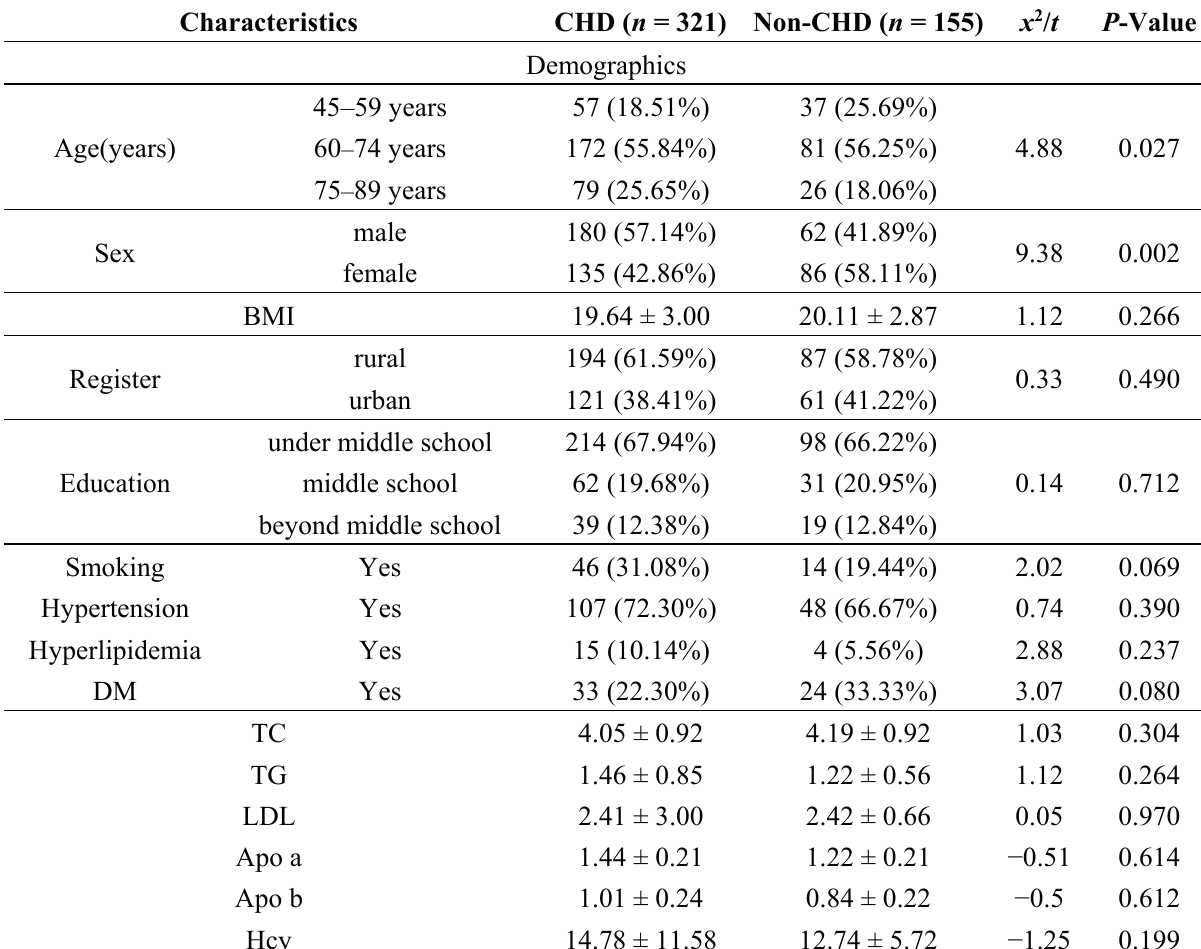
Table 1. Comparison of demographic characteristics and clinical parameters between CHD and non-CHD